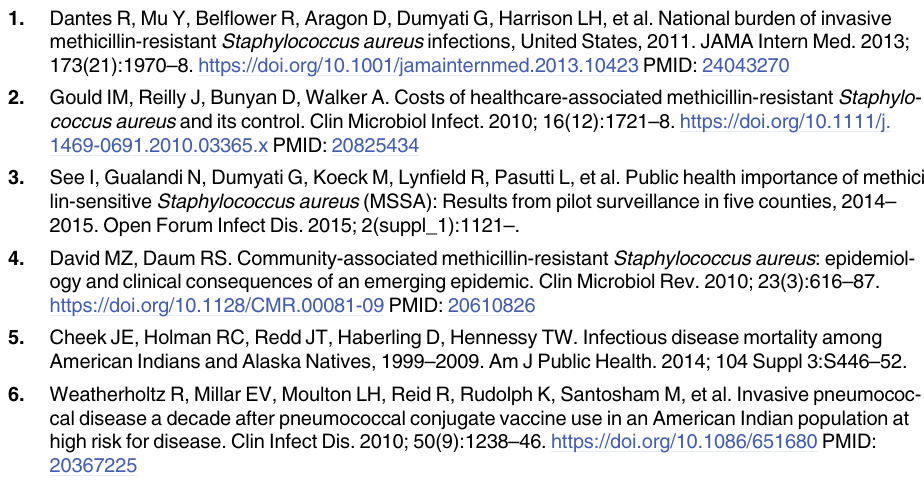
and infection type, on Navajo Nation, May 2016 –April